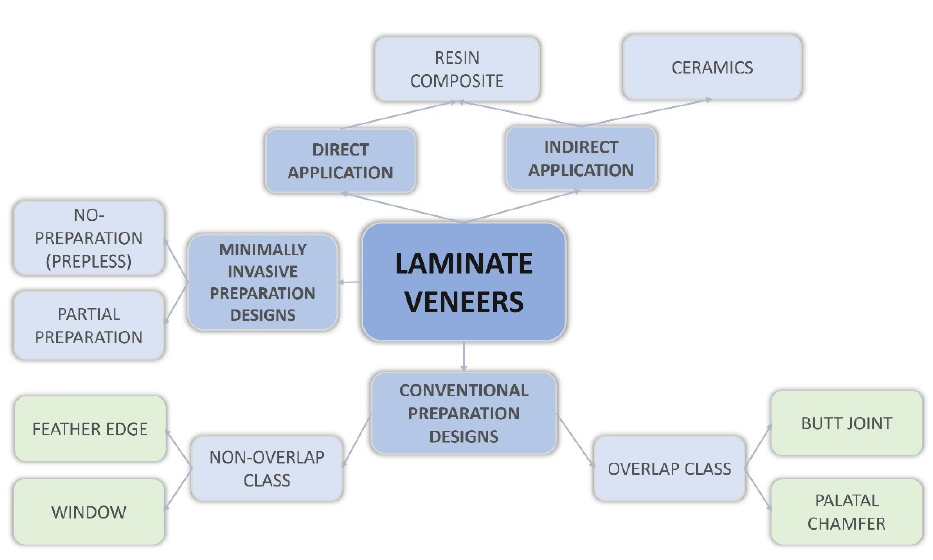
Figure 1. Diagram showing all types of laminate veneers.